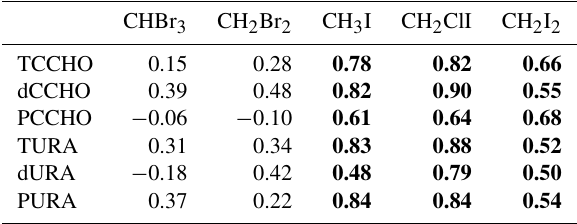
Table 3. Correlations of halocarbons with combined high- molecular-weight (HMW) carbohydrates (CCHO) and uronic acids (URA) from subsurface samples (T – total; d – dissolved; P – partic- ulate) with a sample number of 29 for each variable. Bold numbers indicate significant